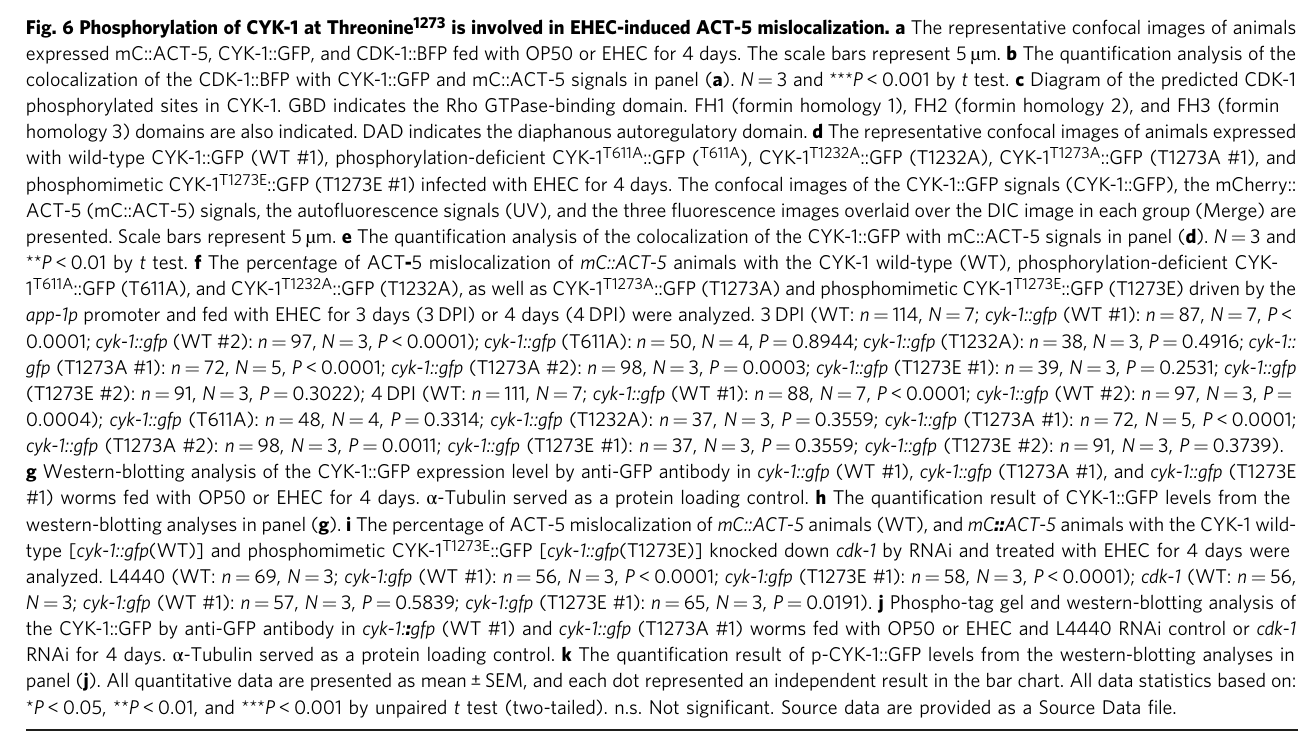
Fig. 6 Phosphorylation of CYK-1 at Threonine 1273 is involved in EHEC-induced ACT-5 mislocalization. a The representative confocal images of animals expressed mC::ACT-5, CYK-1::GFP, and CDK-1::BFP fed with OP50 or EHEC for 4 days. The scale bars represent 5 µ m. b The quanti fi cation analysis of the colocalization of the CDK-1::BFP with CYK-1::GFP and mC::ACT-5 signals in panel ( a ). N = 3 and *** P < 0.001 by t test. c Diagram of the predicted CDK-1 phosphorylated sites in CYK-1. GBD indicates the Rho GTPase-binding domain. FH1 (formin homology 1), FH2 (formin homology 2), and FH3 (formin homology 3) domains are also indicated. DAD indicates the diaphanous autoregulatory domain. d The representative confocal images of animals expressed with wild-type CYK-1::GFP (WT #1), phosphorylation-de fi cient CYK-1 T611A ::GFP ( T611A ), CYK-1 T1232A ::GFP (T1232A), CYK-1 T1273A ::GFP (T1273A #1), and phosphomimetic CYK-1 T1273E ::GFP (T1273E #1) infected with EHEC for 4 days. The confocal images of the CYK-1::GFP signals (CYK-1::GFP), the